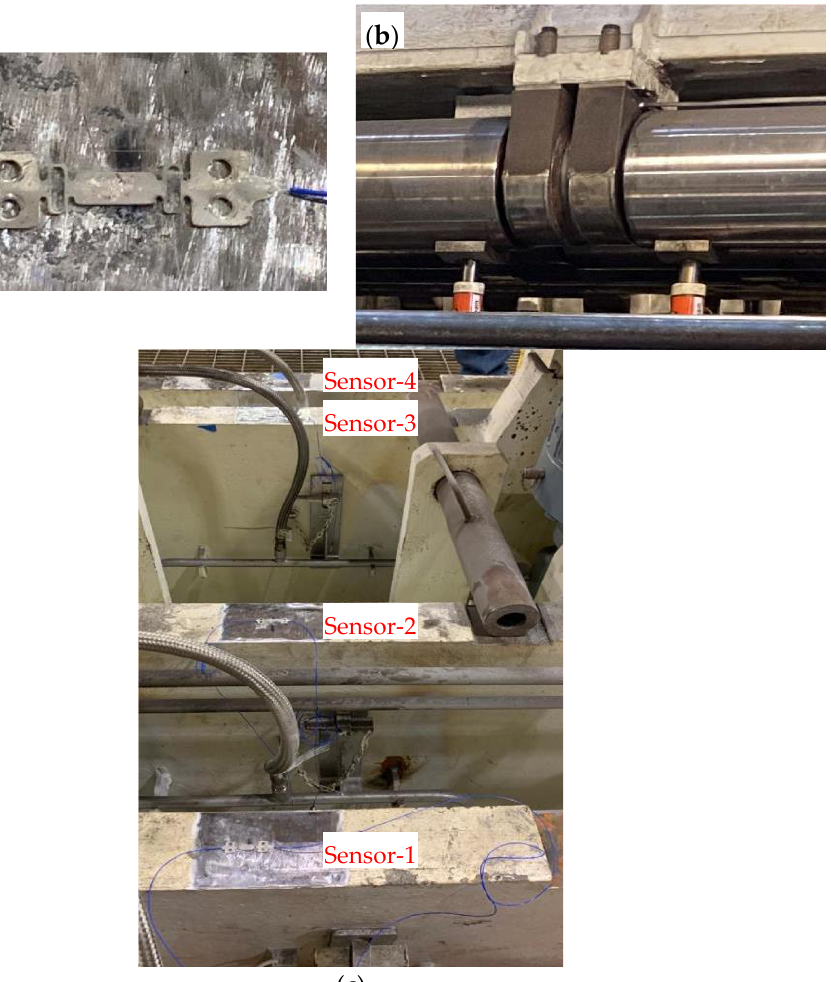
Figure 4. ( a ) FBG strain gauge superglued onto caster roll. ( b ) Hydraulic jacks placed close to bearings. ( c ) Four FBG strain gauges attached to four caster roll support beams.